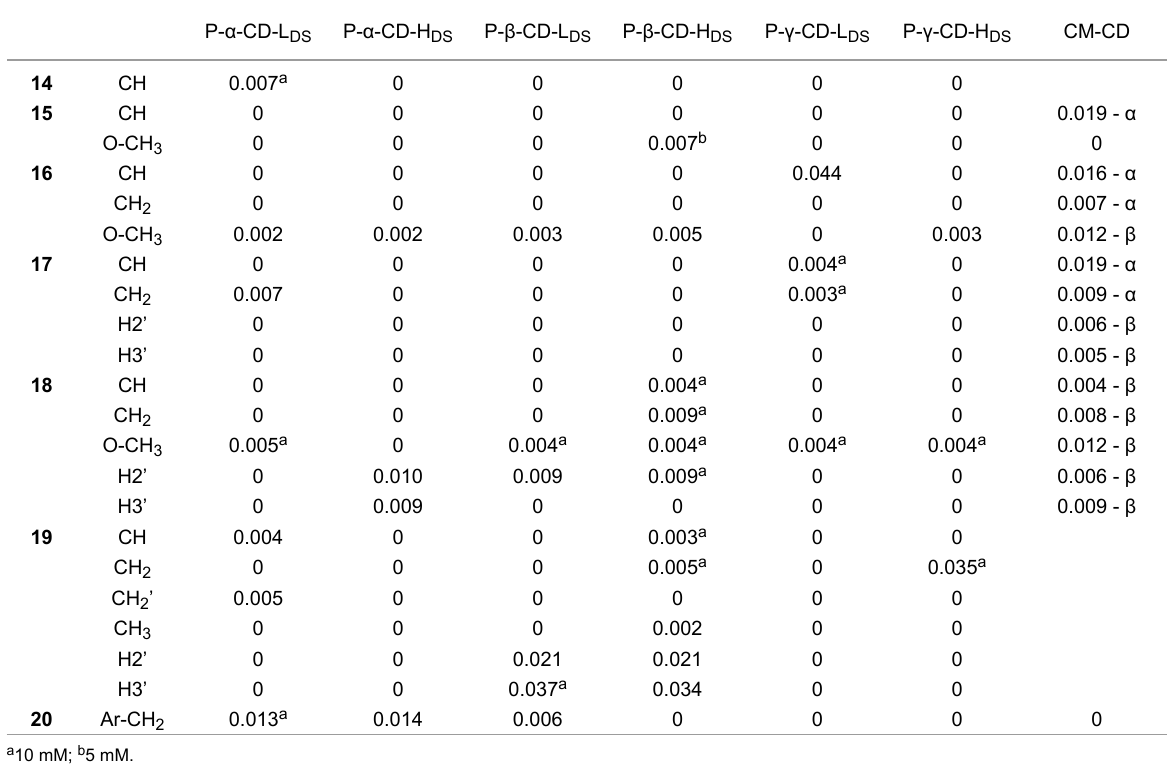
Table 3: Enantiomeric differentiation in ppm in the 1 H NMR spectra (400 MHz) of 14 – 20 (10 mM) with P-CDs and CM-CD [31] in D 2 O. The concentra- tion of the cyclodextrin is 20 mM unless otherwise indicated.